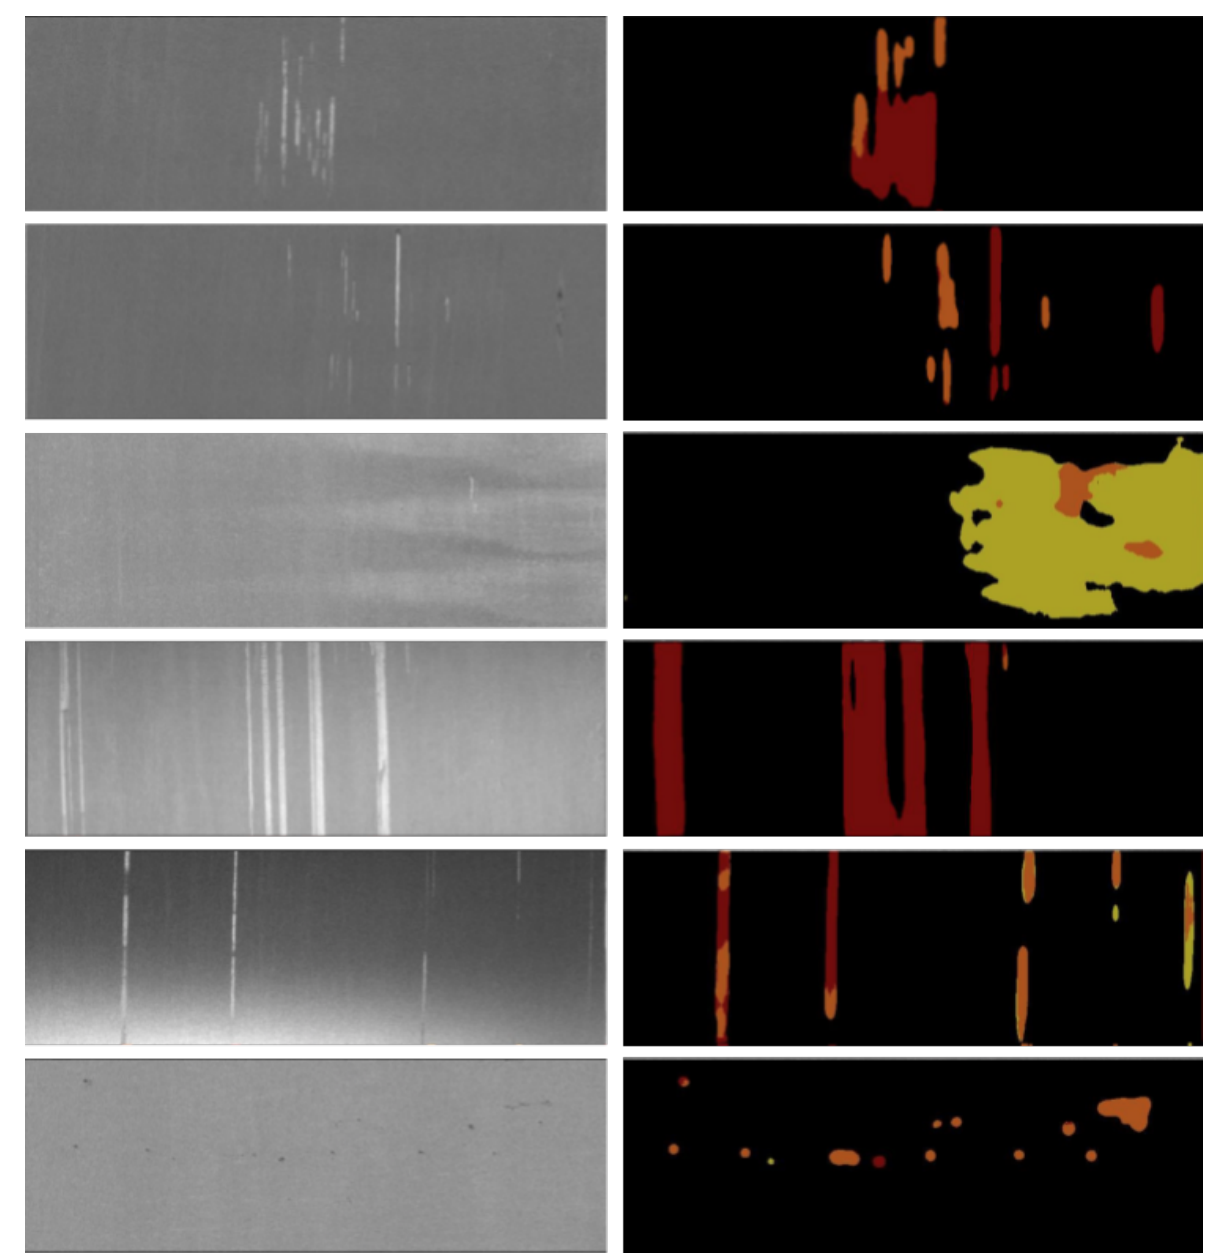
Figure 11. Example predictions of the severity segmentation model (validation data). The model succeeds in detecting most defects while accurately estimating the severity. However, the performance on level 1 severity defects still needs improvement due to erroneous labels, i.e., unlabeled or wrongly labeled